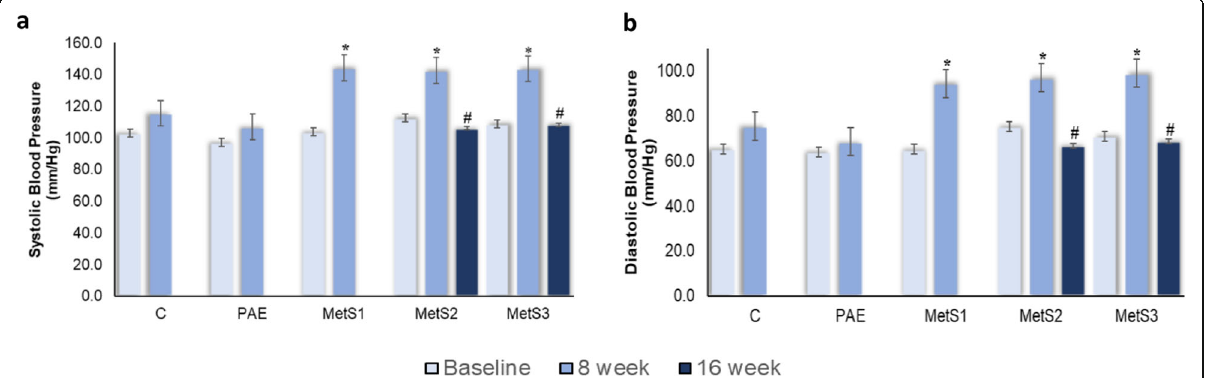
Fig. 3 Blood pressure effects on a systolic and b diastolic BP in C, PAE, MetS1, MetS2 and MetS3. * p < 0.05 compared to 0th week. # p < 0.05 compared to 8th